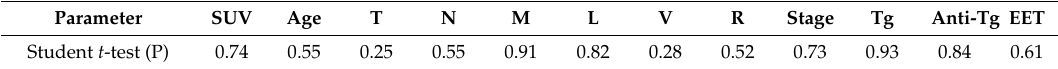
Table 2. Determination P in BRAF + vs. BRAF–.